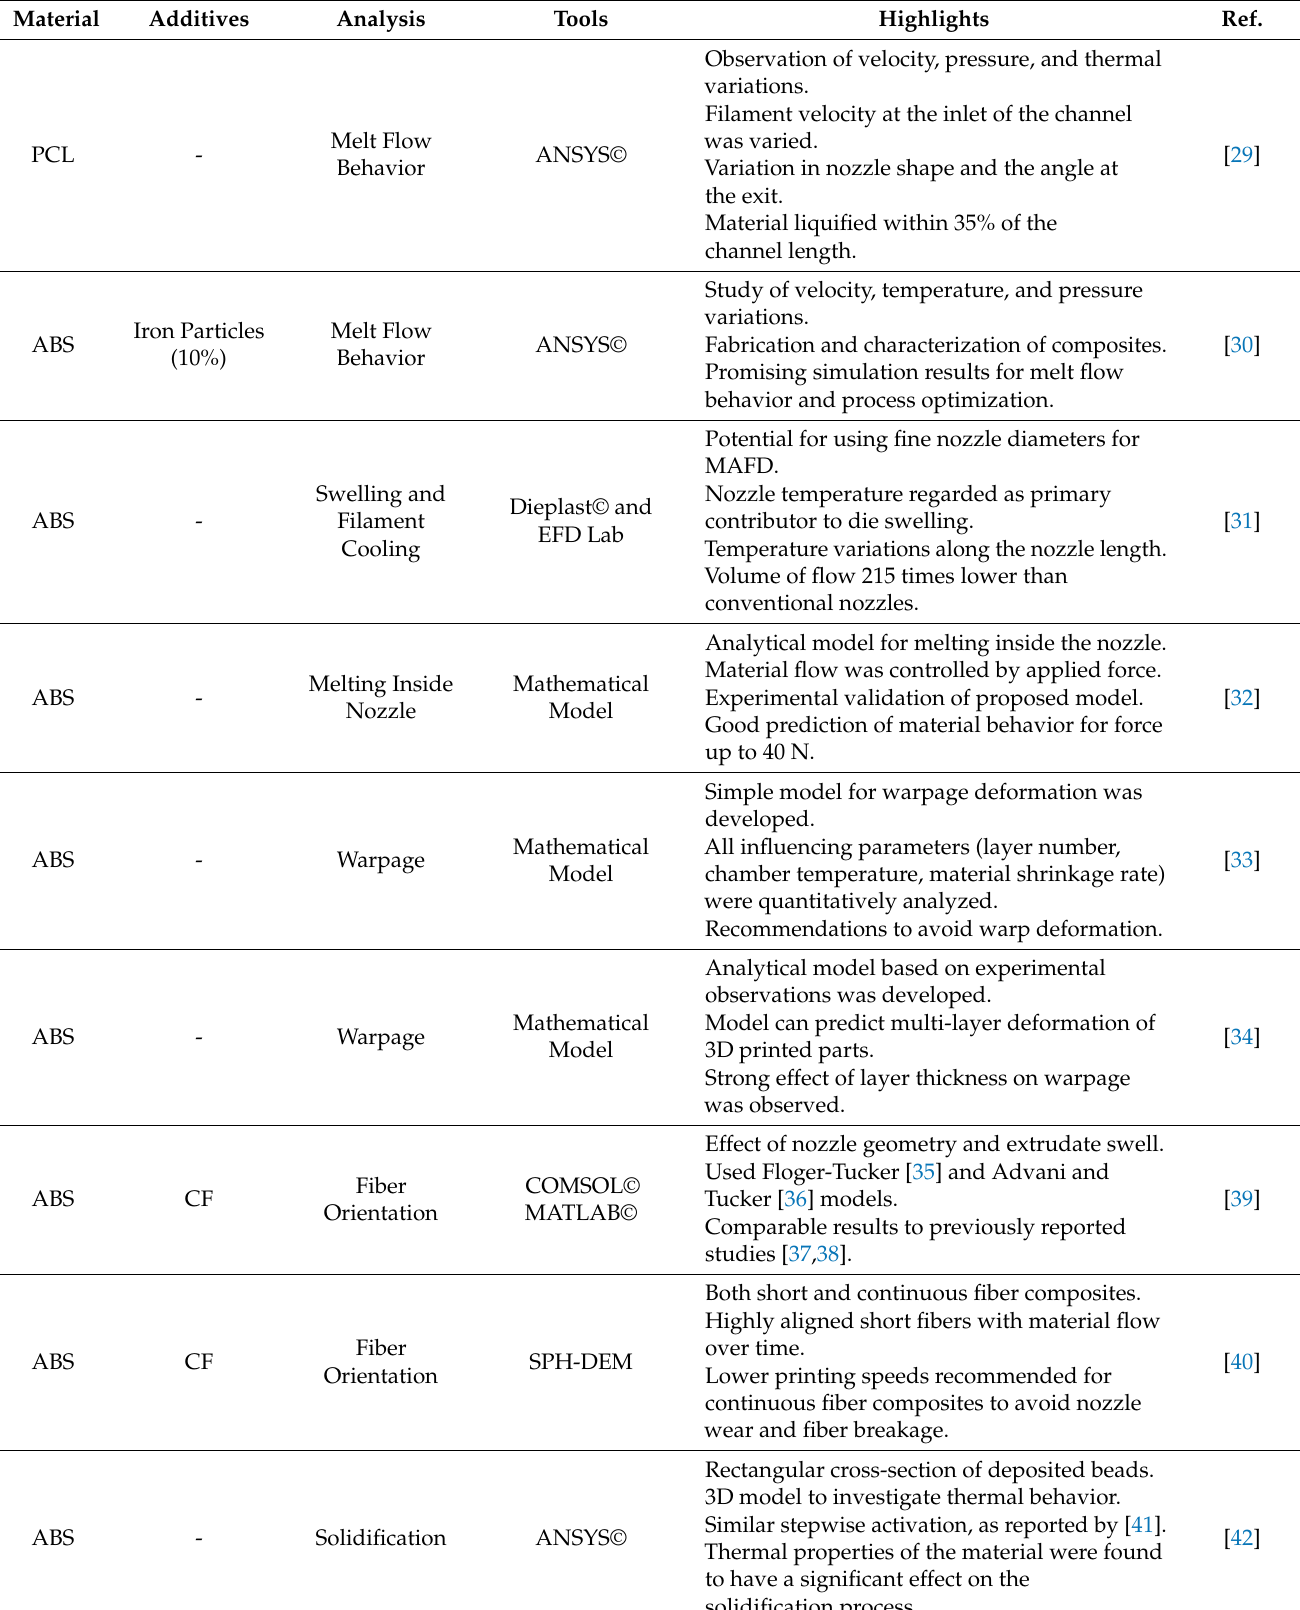
Table 1. Summary of studies reported on the numerical modeling of fused filament fabrication